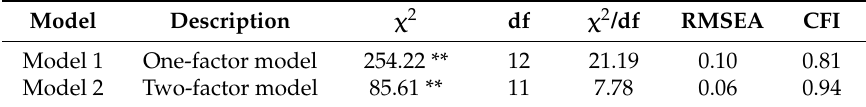
Table 3. Results of Confirmatory Factor Analysis (Seven Items) for Study 1 (Subsample 2: n = 2245), AMOS Model Fit Indices.